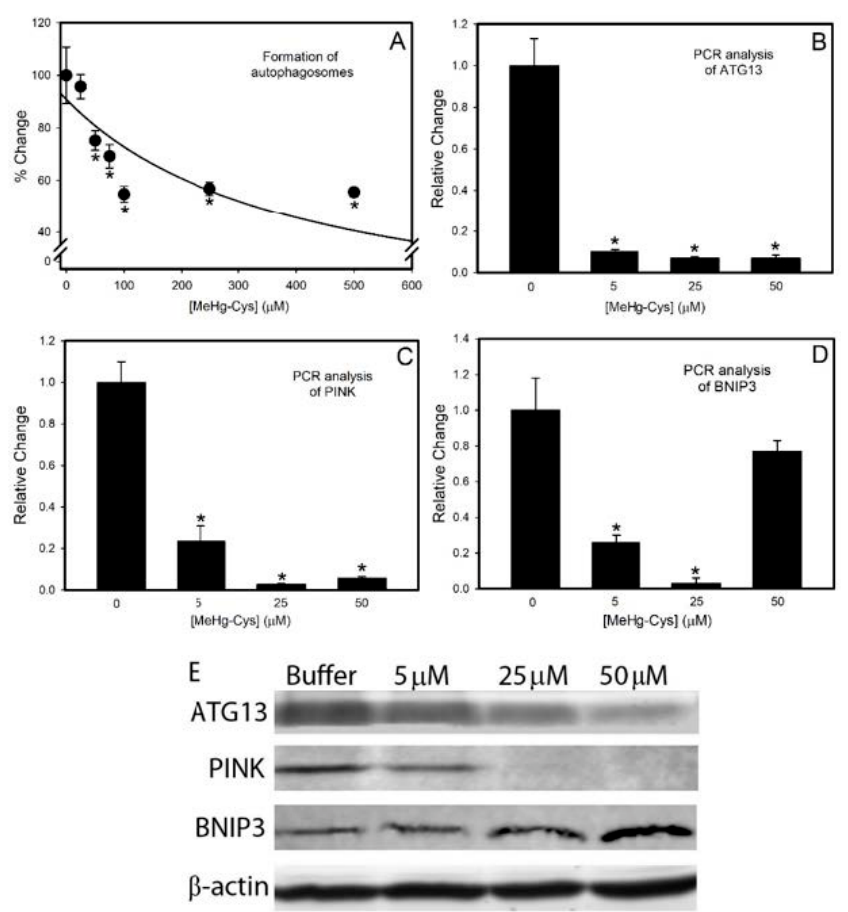
Figure 5. Indicators of autophagy in BeWo cells. BeWo cells were exposed to various concentrations of MeHg-Cys for 30 min at 37 °C, and the formation of autophagosomes was measured ( A ). For analyses of mRNA expression and protein levels, cells were exposed to MeHg-Cys for 16 h at 37 °C. RNA and protein were isolated from the control and exposed cells, and quantitative PCR (qPCR) was used to analyze levels of ATG13 ( B ), PINK ( C ), and BNIP3 ( D ). Western blotting ( E ) measured protein levels of ATG13 (72 kDa), PINK (63 kDa), and BNIP3 (22 kDa). β-actin (42 kDa) was used as the control. Results are presented as mean ± SE. Data represent 3 experiments performed in triplicate. *, significantly different ( p < 0.05) from unexposed cells.